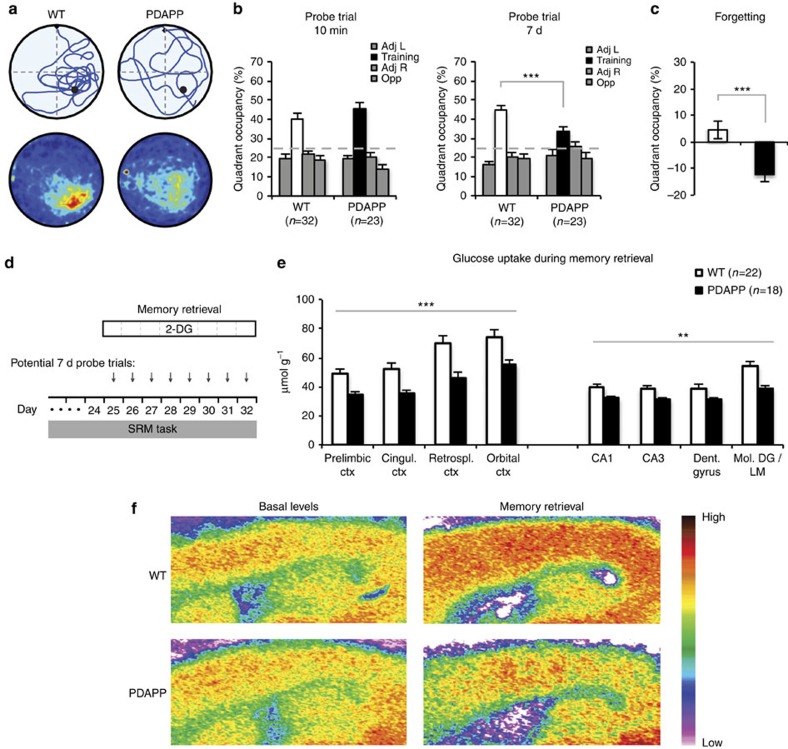
Impairments in memory retrieval and retrieval-associated glucose uptake in young PDAPP mice.(a) Swim path of representative individual animals (top) and group averaged heat-maps (bottom) for probe test at 7 days; only WT mice show a focus on the correct target location. (b) Young PDAPP mice searched equally well as WT mice in the training quadrant of the watermaze relative to the other quadrants in the probe trial 10 min after reaching the pre-defined criterion (ANOVA, genotype × quadrant: F2,110=1.18, P=0.31), but displayed significantly less focused searching at 7 days (genotype × quadrant: F2,120=4.05, P=0.016). The triple interaction of groups × quadrants × memory-delay was highly significant (F2.5,134=6.32, P=0.001, Greenhouse Geisser correction). A planned orthogonal comparison of training quadrant occupancies by WT and PDAPP mice at 7 days also revealed a highly significant difference: F1,134=11.04, P<0.001). Note: The occupancies in the training quadrant are represented by white bars for WT mice and by black bars for PDAPP mice. (c) Change in target quadrant occupancy (7 days minus 10 min) shows modest consolidation in WT mice but forgetting in PDAPP mice (t53=3.67, P<0.001). These data establish the greater forgetting by PDAPP mice over the 7-day (7d)retention period. (d) Experimental design incorporating possible time points for glucose uptake monitoring, given that learning criterion may be reached on any day between session 17 and 24. (e) Glucose uptake in the context of memory retrieval with injection of 2-DG immediately before the 7-d probe trial. Across midline structures in neocortex, a stronger metabolic signal was observed in WT mice than in PDAPP mice (ANOVA, between-subjects comparison: F1,38=14.25, P=0.001). A significant but smaller difference was observed for hippocampus: F1,38=7.53, P=0.01). (f) Representative pseudo-colour 2-DG images of brain sections from mice of the basal levels group (left) and the memory retrieval group (right) show the increase in metabolism in WT mice at retrieval and its absence in PDAPP animals, this difference more evident in the neocortex than in the hippocampus. Note: The scale bar at the side of the image serves the sole function of indicating that ‘warm' colours represent high 2-DG levels, whereas ‘cold' colours represent low levels (see the Methods for explanation of quantification). **P<0.01, ***P<0.001. Means±1 s.e.m. Cingul., cingulate, Ctx, cortex; Retrospl., retrosplenial.